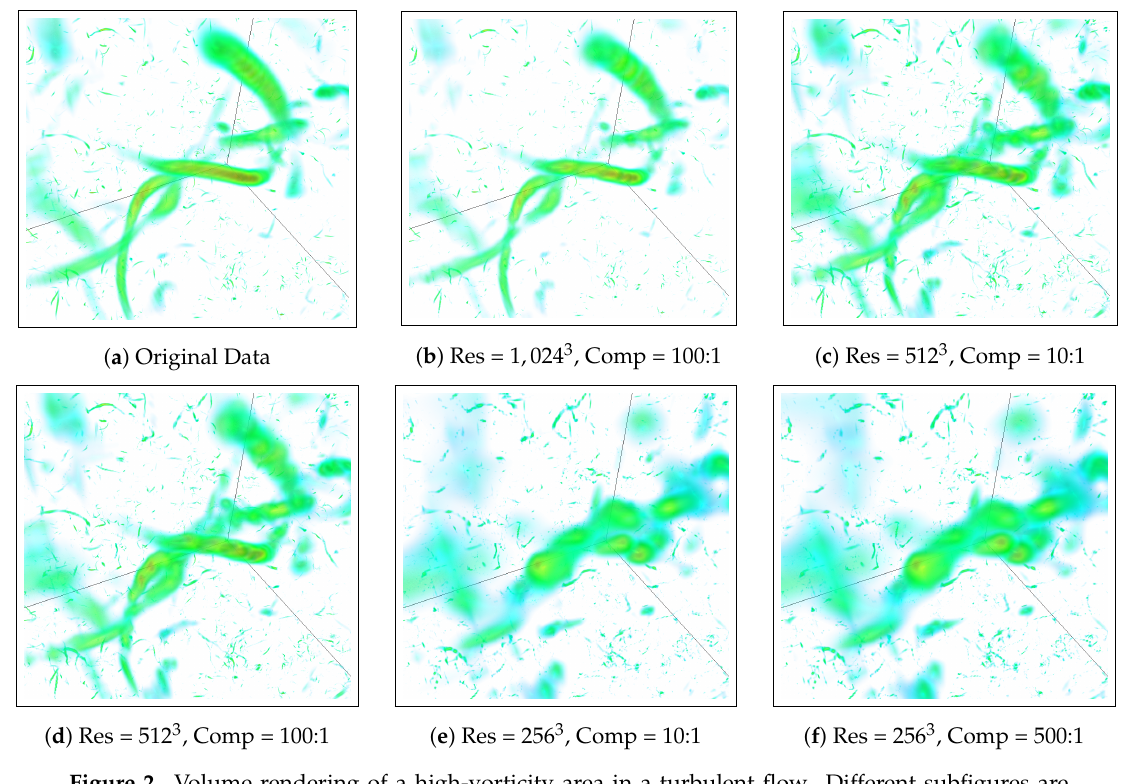
Figure 2. Volume rendering of a high-vorticity area in a turbulent flow. Different subfigures are generated using different versions of the same data. These versions differ in resolutions (Res) and lossy compression ratios (Comp), as noted in the subcaptions. ( a ) represents the ground truth rendering from the original data.